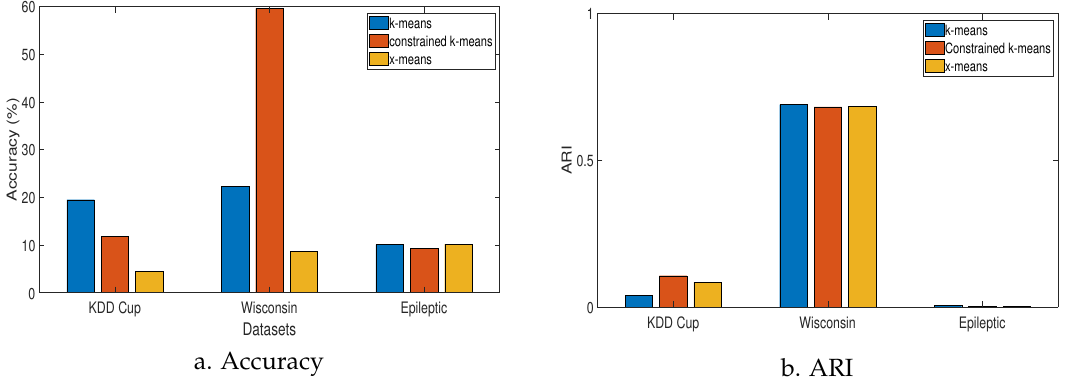
Figure 3. Performance of k-means variants addressing initialization issue.